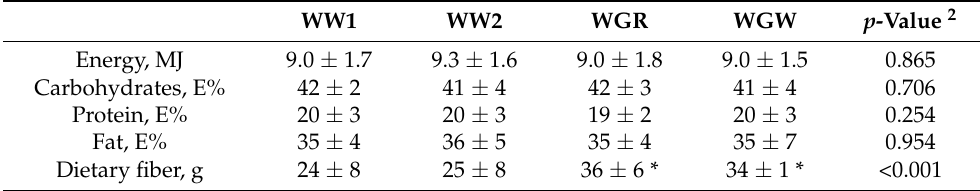
Table 3. Mean daily intakes 1 of energy and nutrients during the 1-week diet periods (n =